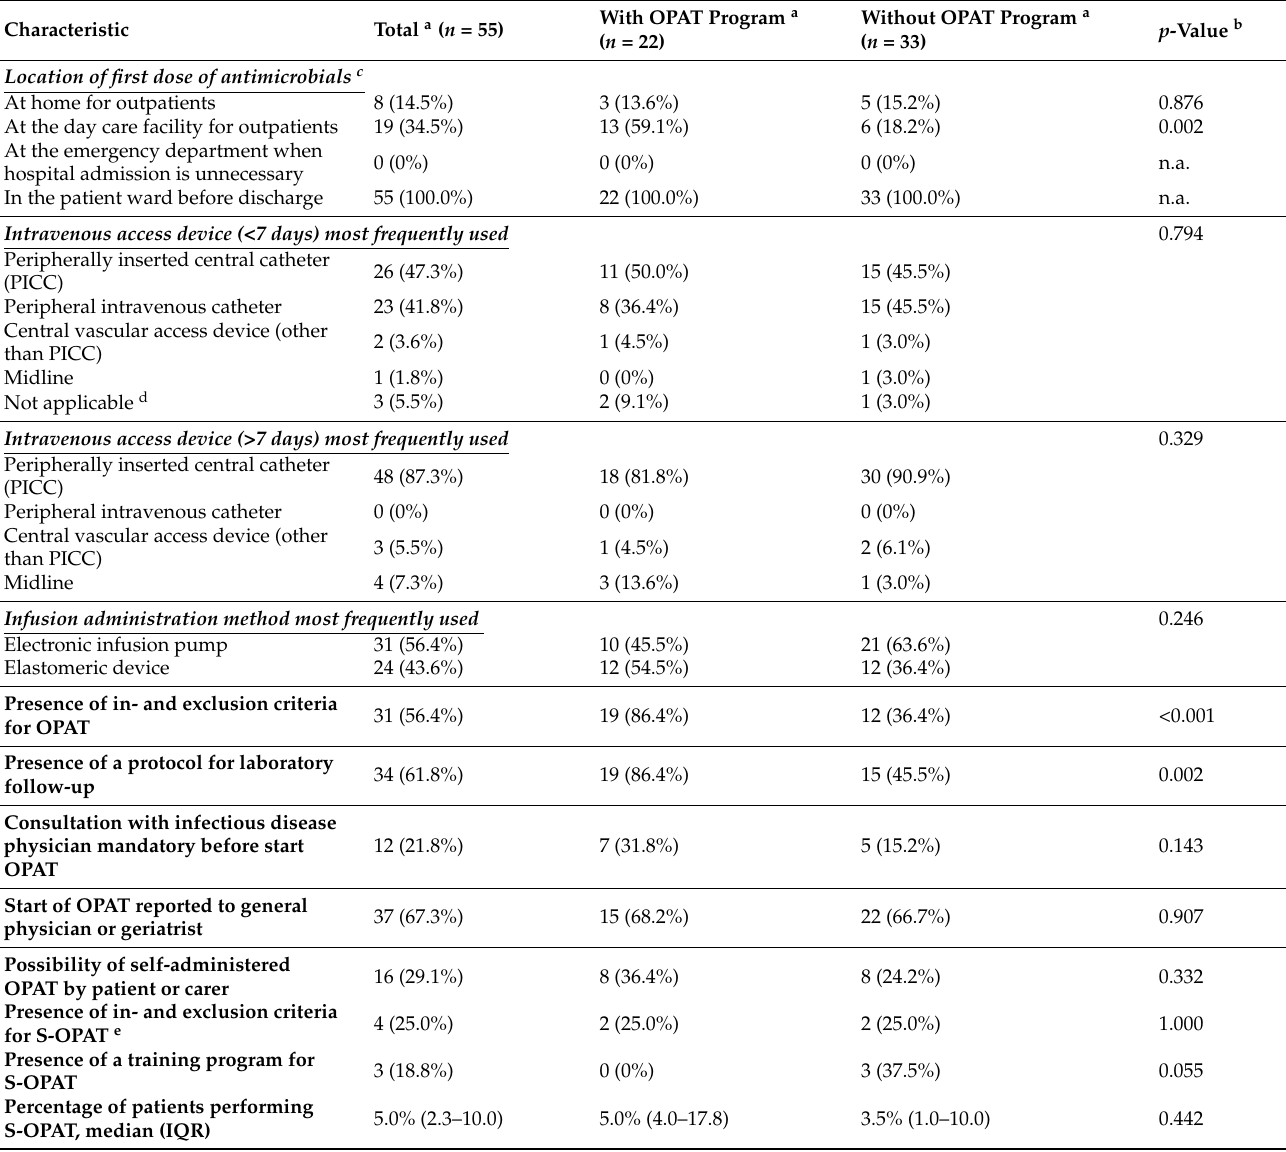
Table 2. Organisation of OPAT care compared between hospitals with and without an OPAT